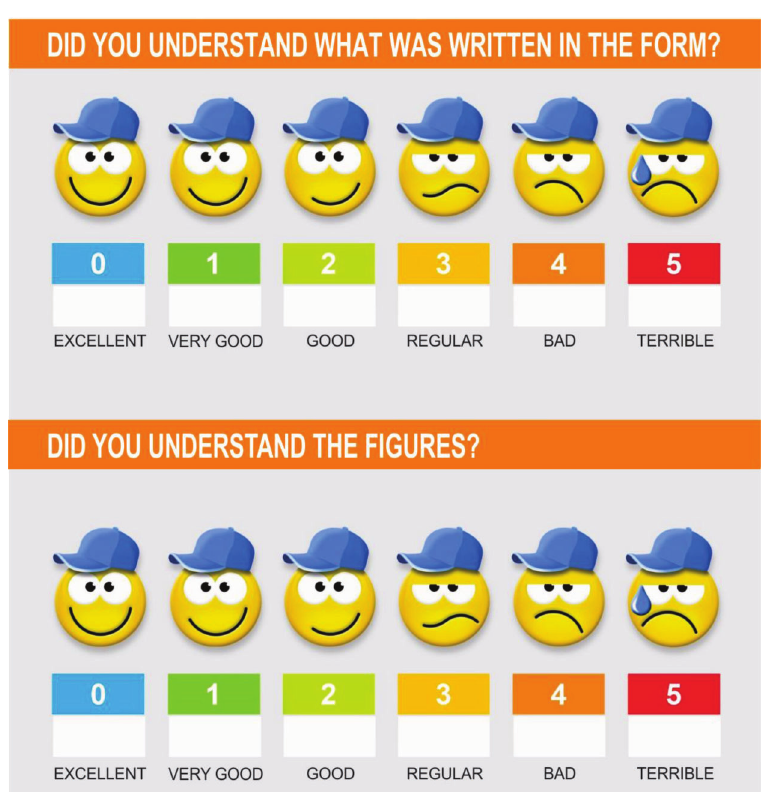
Figure 2 - Likert scale